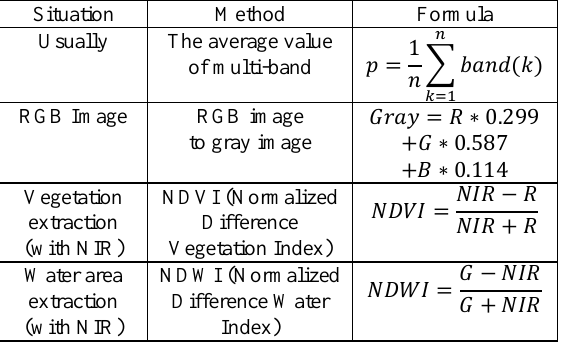
Table 1. Transform a multi-band image to a single band image